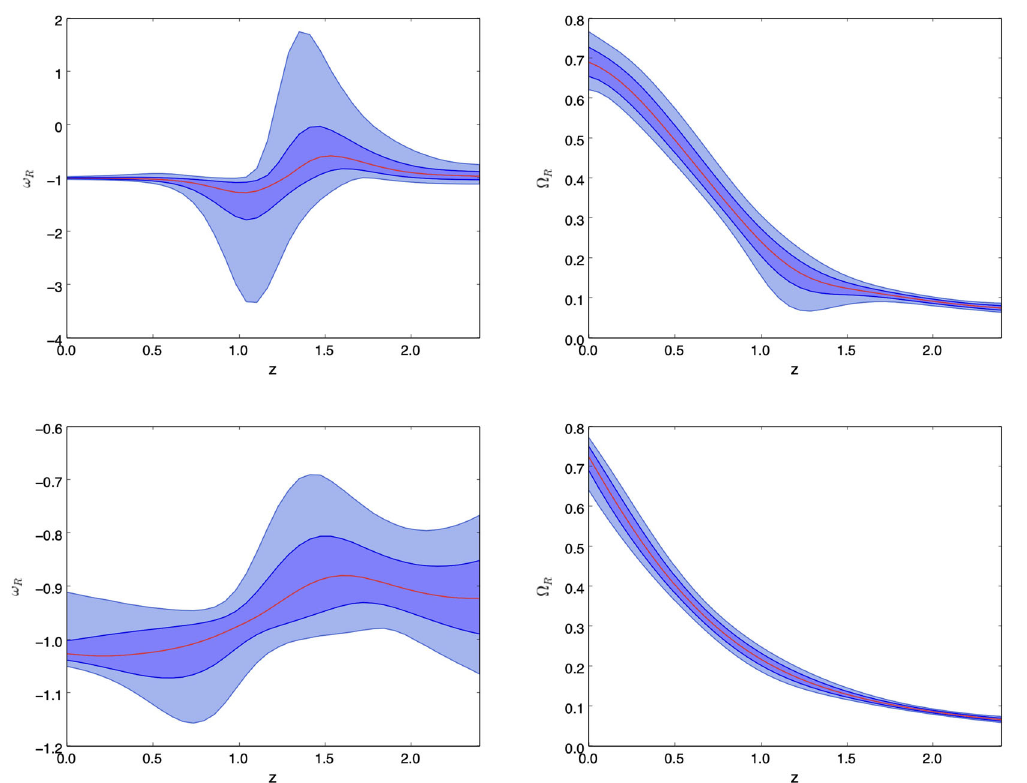
Fig. 7 The GP reconstruction of ω R and (cid:13) R for the 30 H ( z ) samples deduced from the differential age method with 10 additional samples obtainedfromtheradialBAOmethod(Table1)ispresentedontheupper panel, when H 0 = 73 . 52 ± 1 . 62 km s − 1 Mpc − 1 has been merged to the expansion rate data used in the GP. The bottom panel represents the GP reconstruction of ω R and (cid:13) R , when H 0 = 67 . 40 ± 0 . 5 km s − 1 Mpc − 1 has been merged to the expansion rate data used in the GP. The obtained reconstruction is for the f ( R ) model given by Eq. (21). The solid line